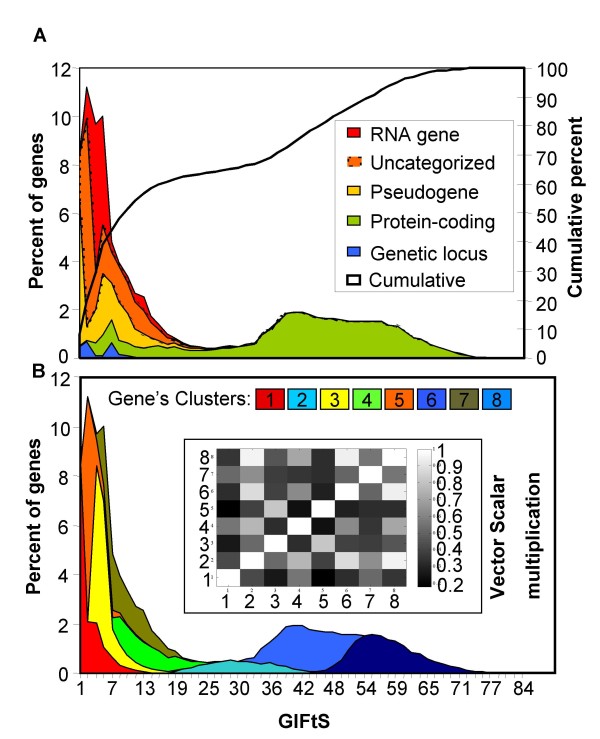
Distribution of GeneCards Inferred Functionality Scores (GIFtS). (A) Dissection of GIFtS by gene categories. (B) Clustering analysis of sources of the GIFtS tool (with highest significance for cluster 6, T-test for difference of means, p < 0.05). Inner frame presents correlation between clusters (highest correlation -1) calculated by scalar-multiplication of unit vectors of cluster centers.